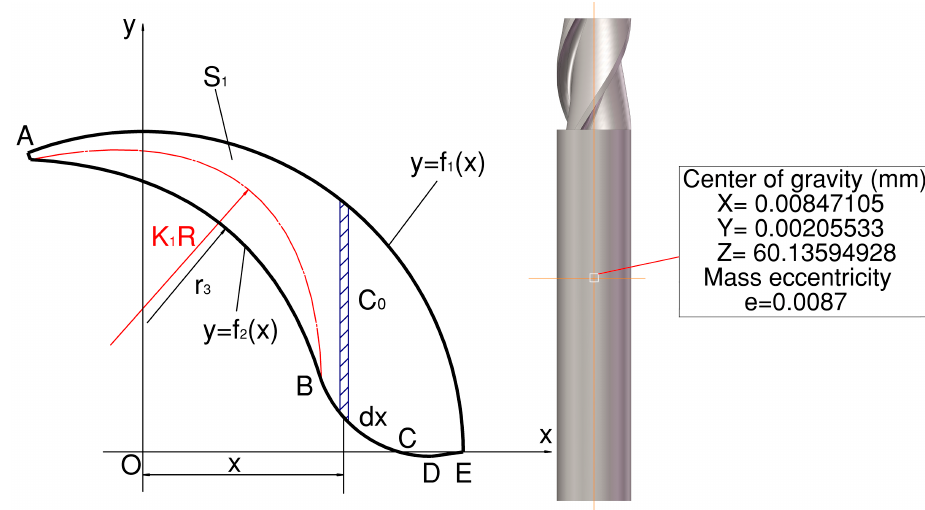
Figure 5. Geometric model of equal pitch equal helix end milling cutters.